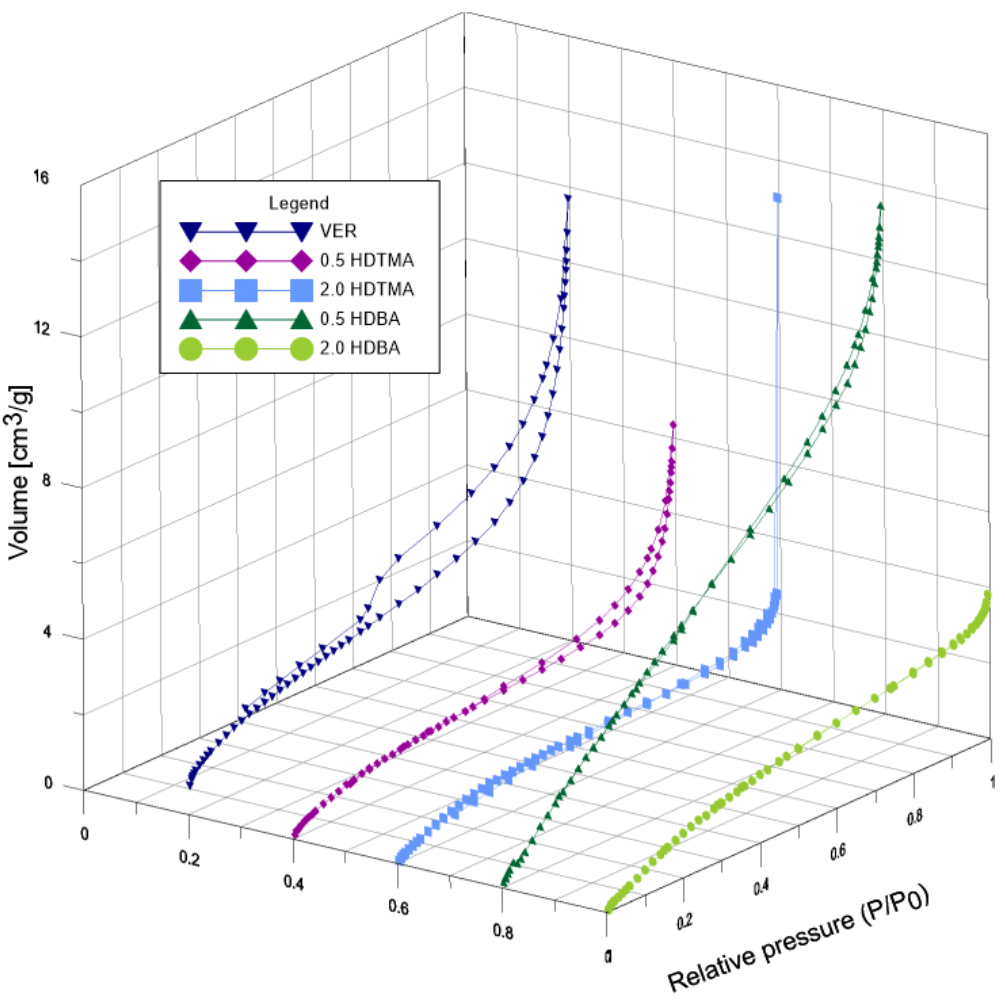
Figure 4. Comparison of N 2 adsorption and desorption isotherms at –196 °C for VER, 0.5 and 2.0 HDTMA, and 0.5 and 2.0 HDBA. Table 2. The textural parameters of VER, 0.5 and 2.0 HDTMA, and 0.5 and 2.0 HDBA.